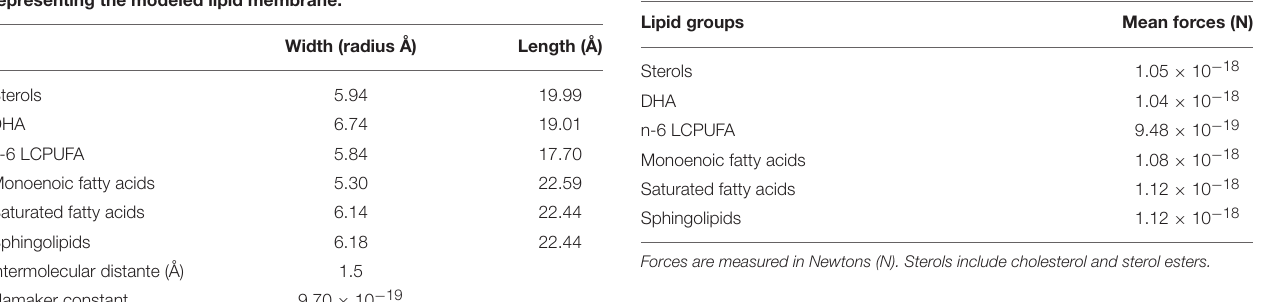
TABLE 2 | Mean force of interaction between lipid